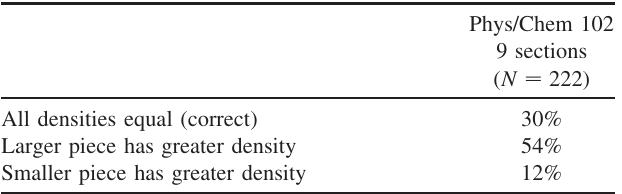
TABLE II. Student responses to the broken-block density problem (Fig.